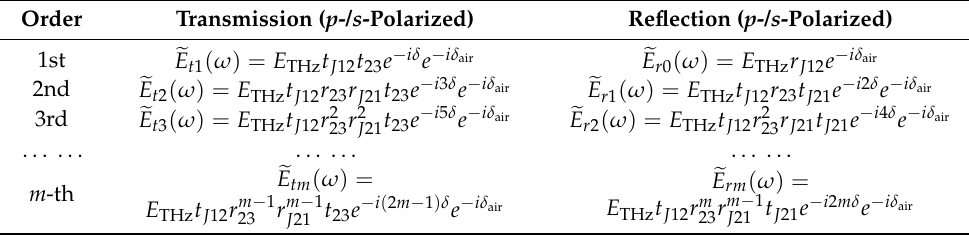
Table 1. The electric fields of the transmitted and reflected waves with different orders. Order